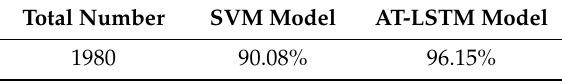
Table 12. Model recognition accuracy of 0 s in